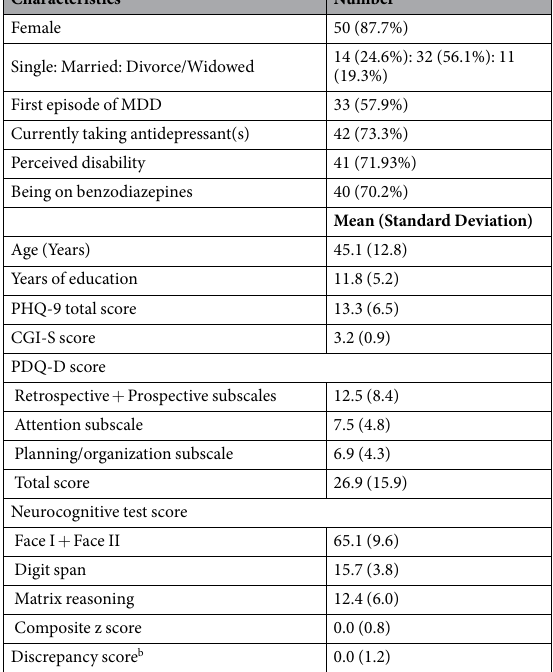
Table 1. Clinical and socio-demographic characteristics of 57 patients with major depressive disorder. a ≥ 1 SDS subscale ≥ 5 points. b Composite NCT z score subtracted by corresponding reversed PDQ-D z score. CGI-S = Clinical Global Impression, Severity Scale; PDQ-D = Perceived Deficits Questionnaire for Depression; PHQ-9 = Patient Health